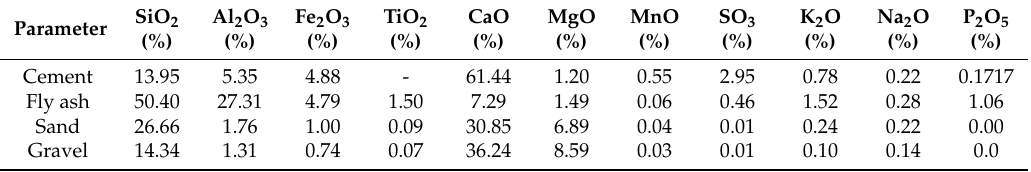
Table 1. Chemical composition of raw materials used in the production of concrete